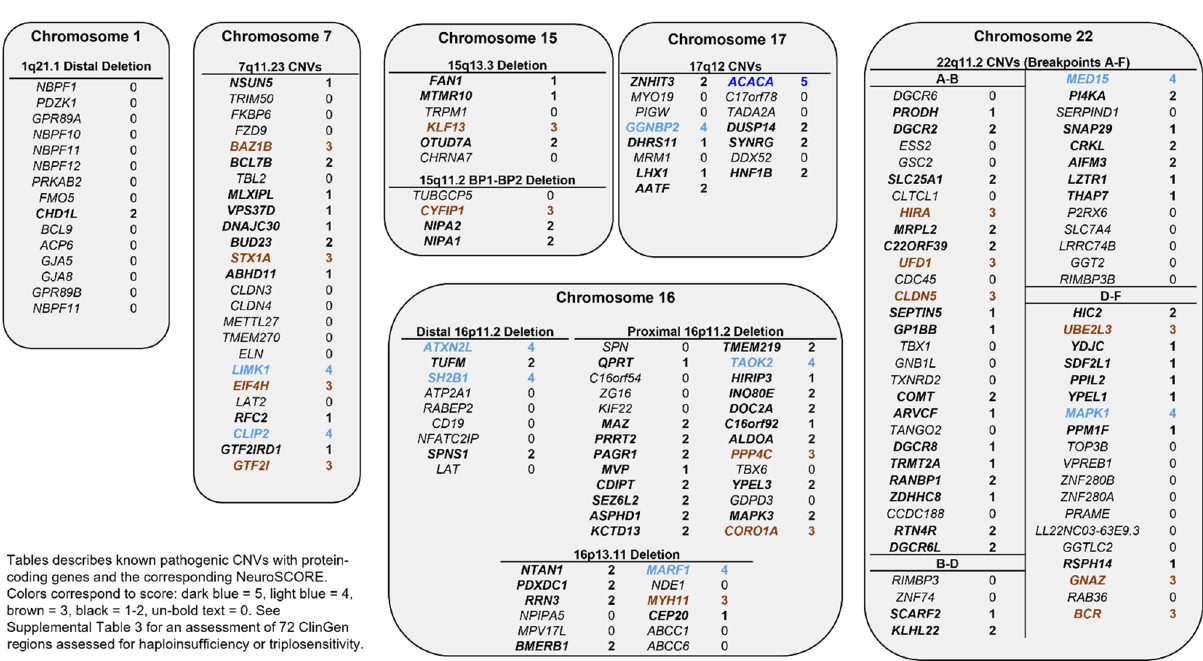
Figure 4. Common neurodevelopmental microdeletion/Duplication syndromes with gene level